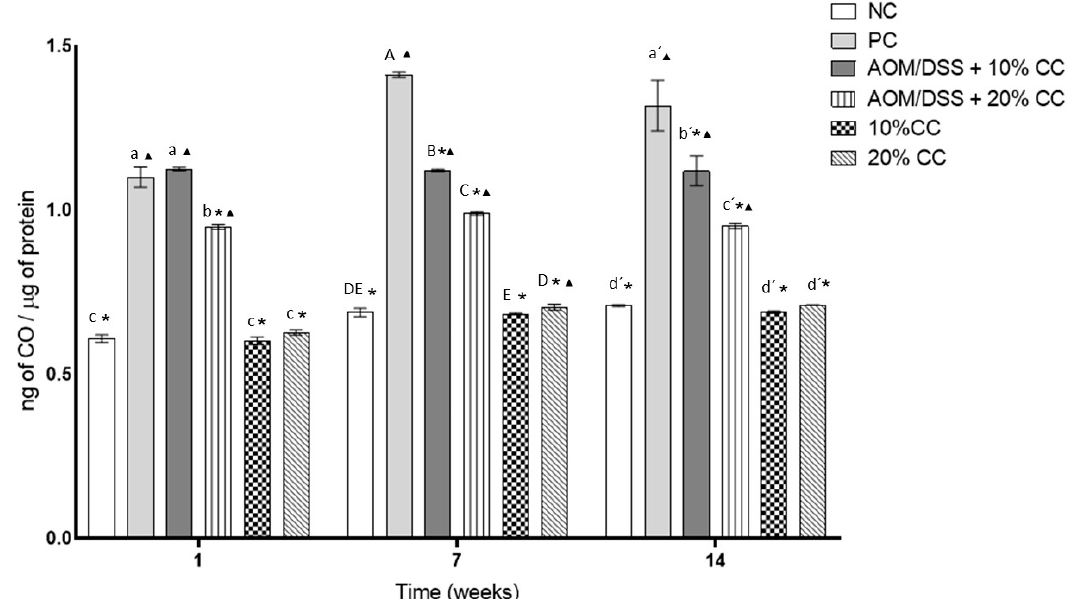
Figure 3. Content of oxidized carbonyl groups (CO) in colon due to the effect of oxidation caused by AOM/DSS in BALB/c mice in three periods. Lowercase letters correspond to Week 1, uppercase letters correspond to Week 7, and raw letters correspond to Week 14. * means significant difference from the PC in the same evaluation week and ▲ significant difference with respect to the NC in the same evaluation week. One-factor ANOVA ( p ≤ 0.05), Dunnett’s test. Different letters indicate significant difference ( p < 0.05) in the same evaluation week by Tukey’s test. Values are presented as the mean ± S.D. from four experimental replicas.